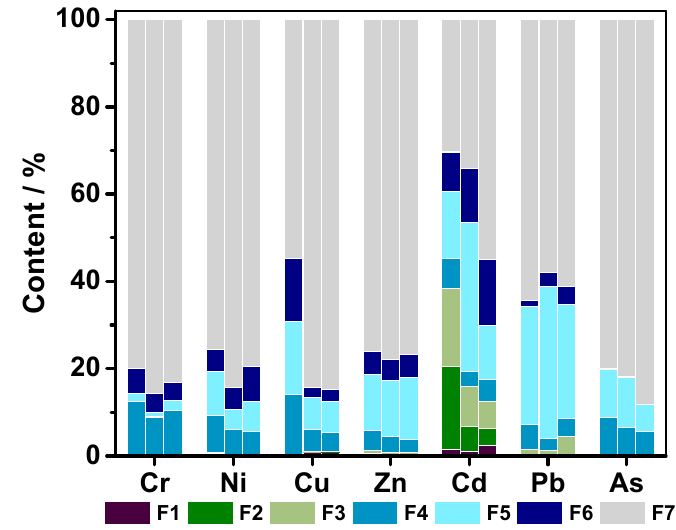
Figure 5. Chemical fractionations of Cr, Ni, Cu, Zn, Cd, Pb and As in surface (see in the left column), middle (see in the middle column) and deep soils (see in the right column) of the study area (F1, F2, F3, F4, F5, F6 and F7 represent water soluble, exchangeable, carbonate-bound, humic acid-bound, Fe and Mn oxide-bound, refractory organic matter-bound, and residual fractions, respectively).